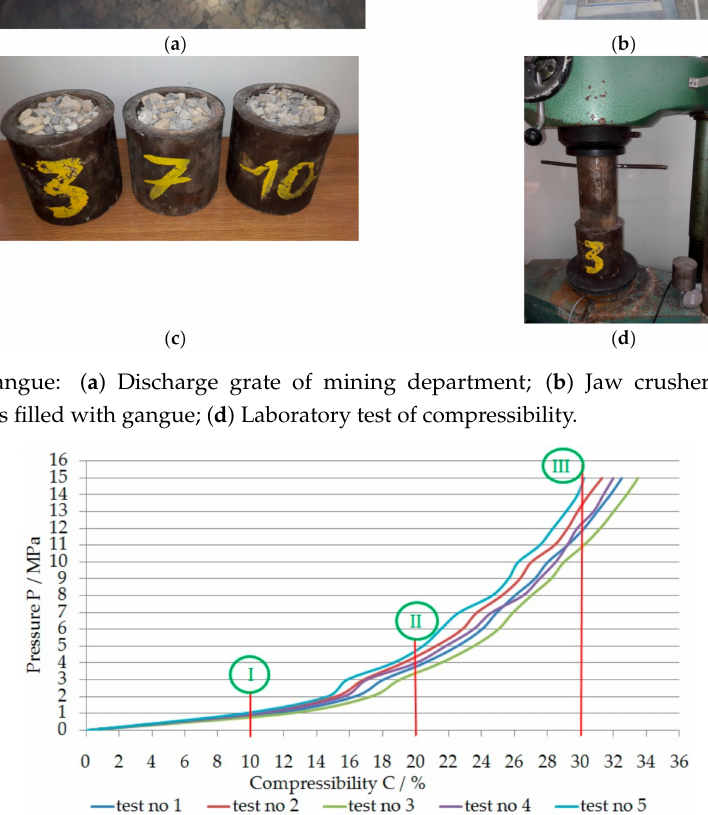
Figure 5. Pressure–compressibility characteristics of gangue (dolomitic limestone): I, II, III—10%, 20%, and 30% of compressibility,